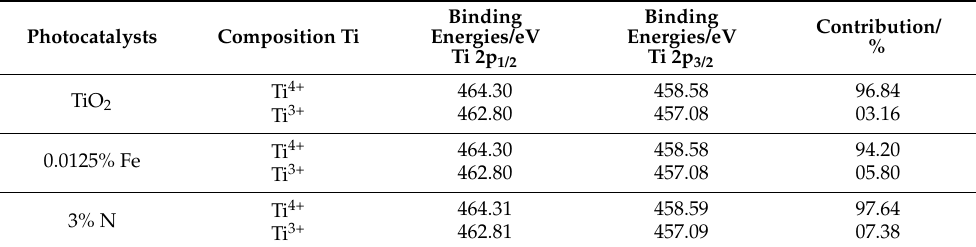
Table 2. Binding energies/eV and contribution of the high-resolution spectra of Ti 2p present in the photocatalysts. Values are obtained from high-resolution XPS spectra in Figure 6.